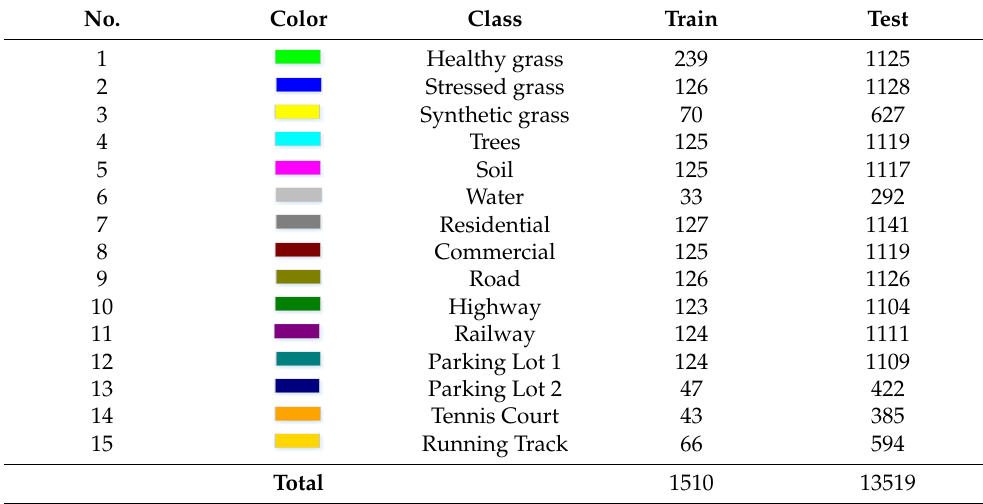
Table 3. The information of sample numbers of the Houston 2013 dataset.